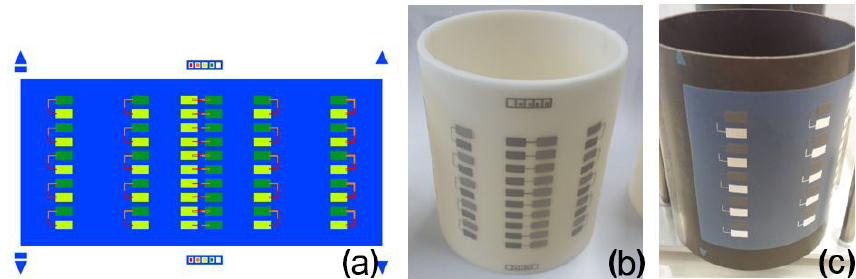
Figure 9. Tubular screen-printing: (a) screen-printing layout consisting of up to 30 thermocouples on a tubular surface, (b) screen-printing on an aluminium oxide substrate and (c) screen-printing of glass insulation paste on steel 1.4828.